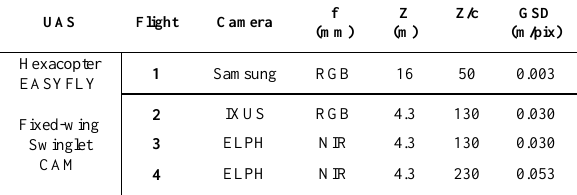
Table 1 – Summary of the UAS flights characteristics, cameras parameters and Ground Sampling Distance (GSD).